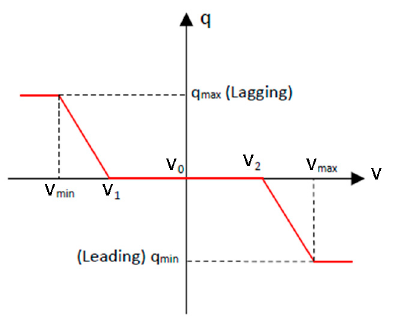
Figure 3. Best Local Control strategy according to [26].